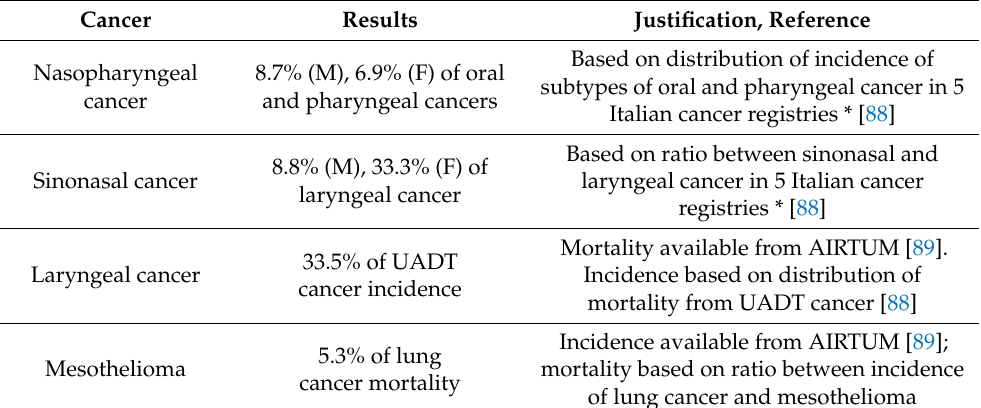
Table A1. Estimate of the number of cases of cancers for which no national data are